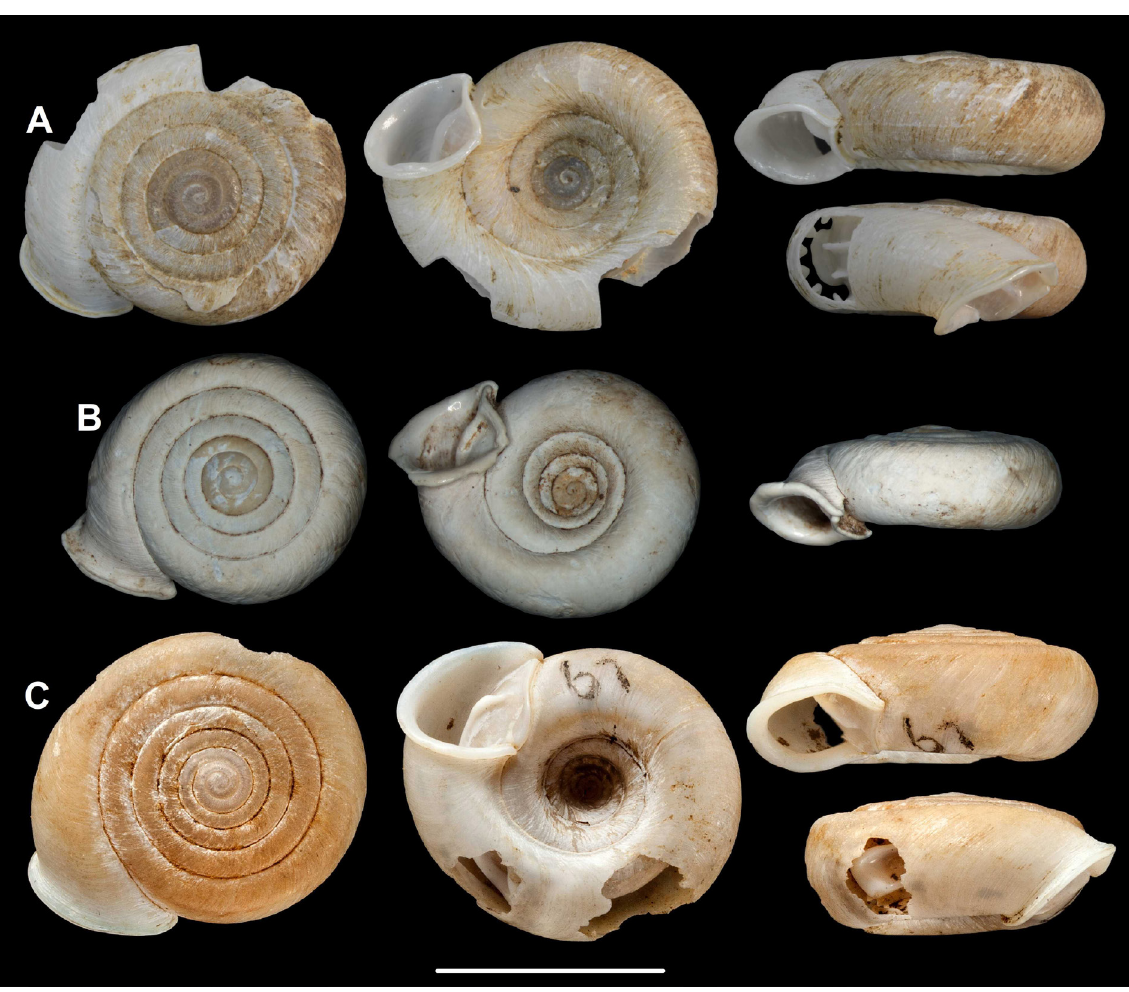
Fig. 19. Shells of species of Chersaecia Gude, 1899. A . C. leiophis (Benson, 1860), holotype of P. degerbolae Solem, 1966 (ZMUC-GAS-485). B . C. leiophis from Thailand (UF 346988). C . C. leucochila (Gude, 1897) comb. nov., holotype (NHMUK 1922.8.29.39). Scale bar = 10 mm. Photos: B. Páll-Gergely (A), T. Deli (B), H. Taylor